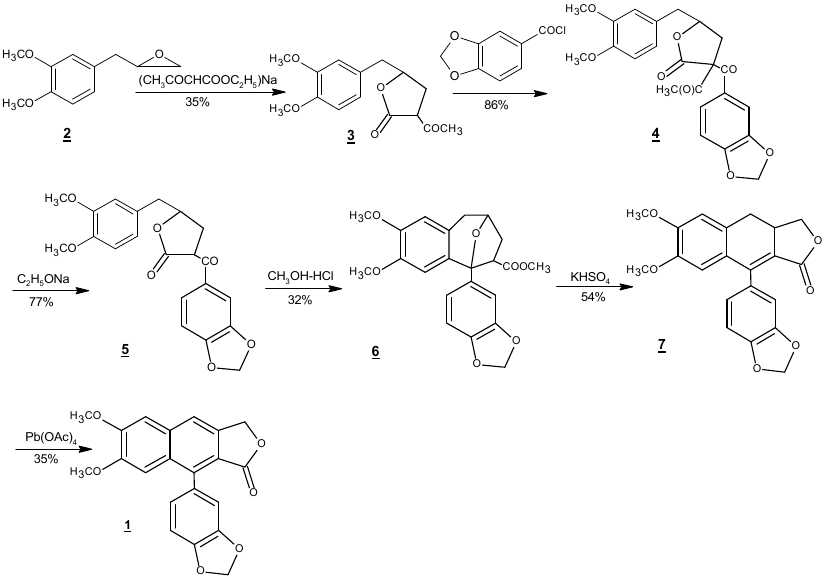
Scheme 2. Total synthesis of justicidin B ( 1 ) from methyleugenoloxide ( 2 ) with an overall yield of 1%–2% [42].